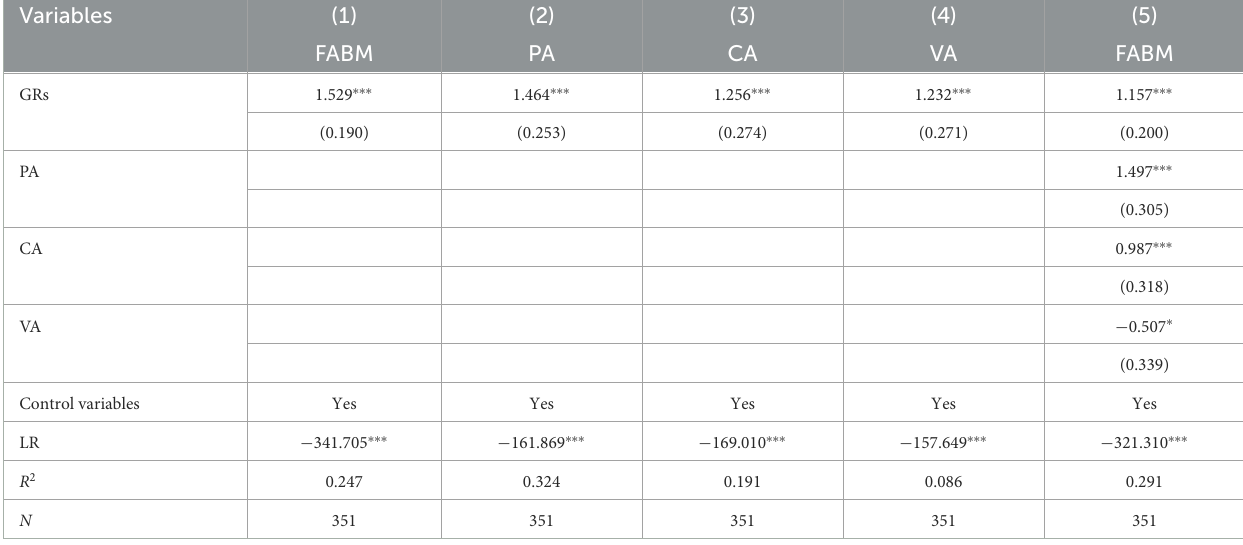
TABLE 7 Robustness test.